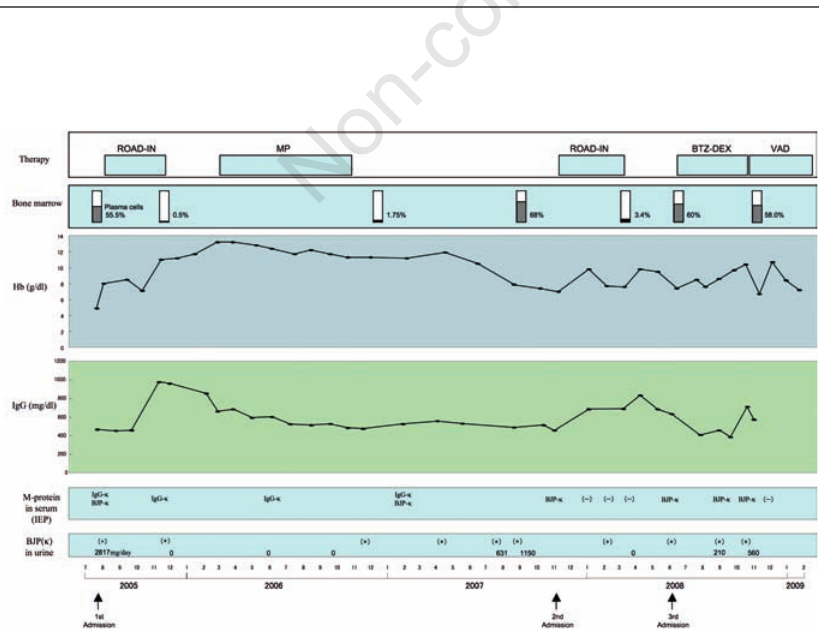
4. Serum immunofixation electrophoresis revealed a faint IgG band and a clear band of BJP ( κ )